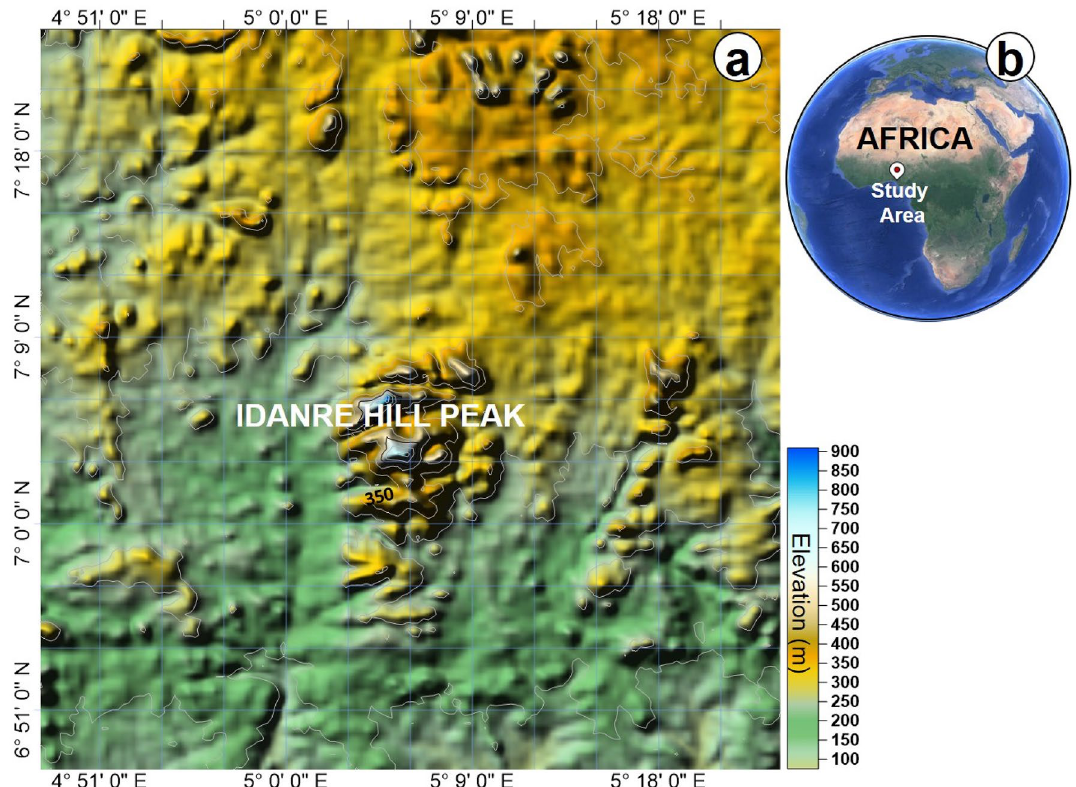
Figure 1. Location map of the study area. ( a ) Topographic map of the study area downloaded from Topex global topography data (https:// topex. ucsd. edu/ cgi- bin/ get_ data. cgi) and ( b ) Inset map showing location of the study area in the context of